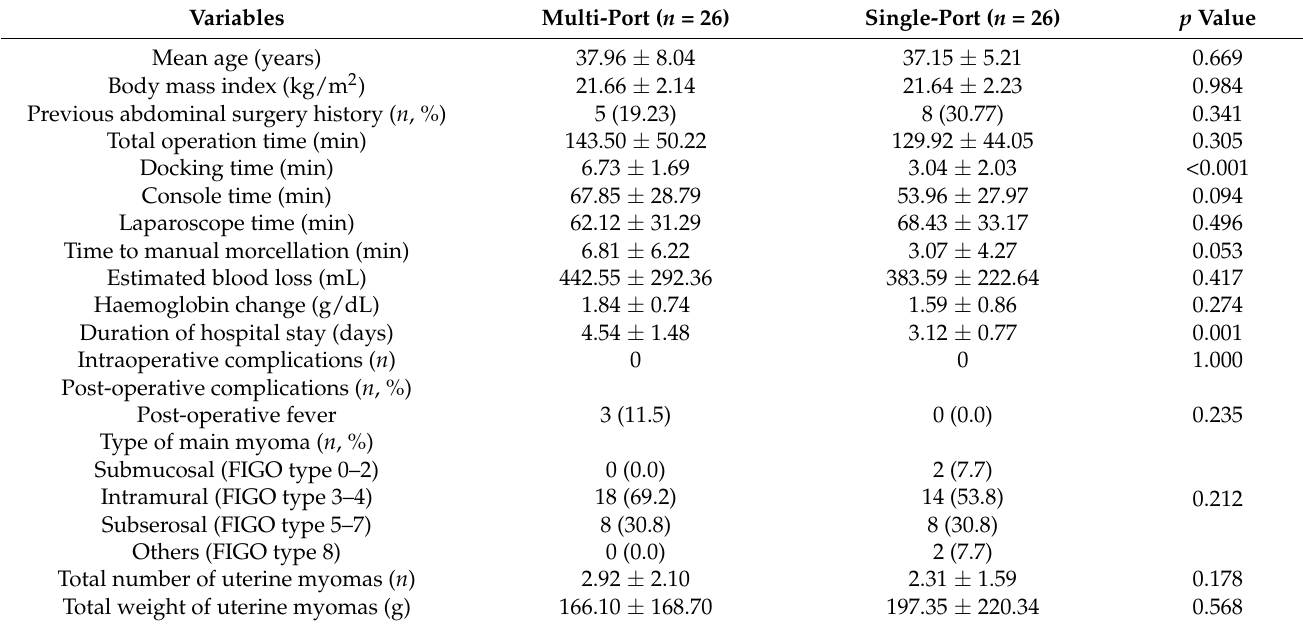
FIGO = International Federation of Gynaecology and